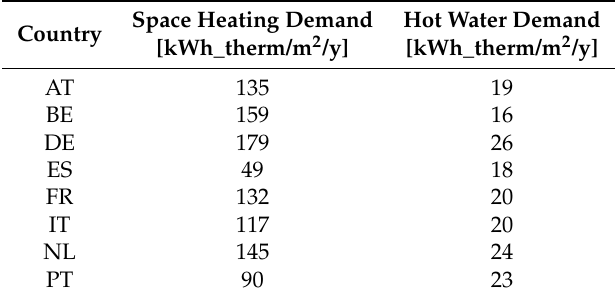
Table A7. Average space heating and hot water demands